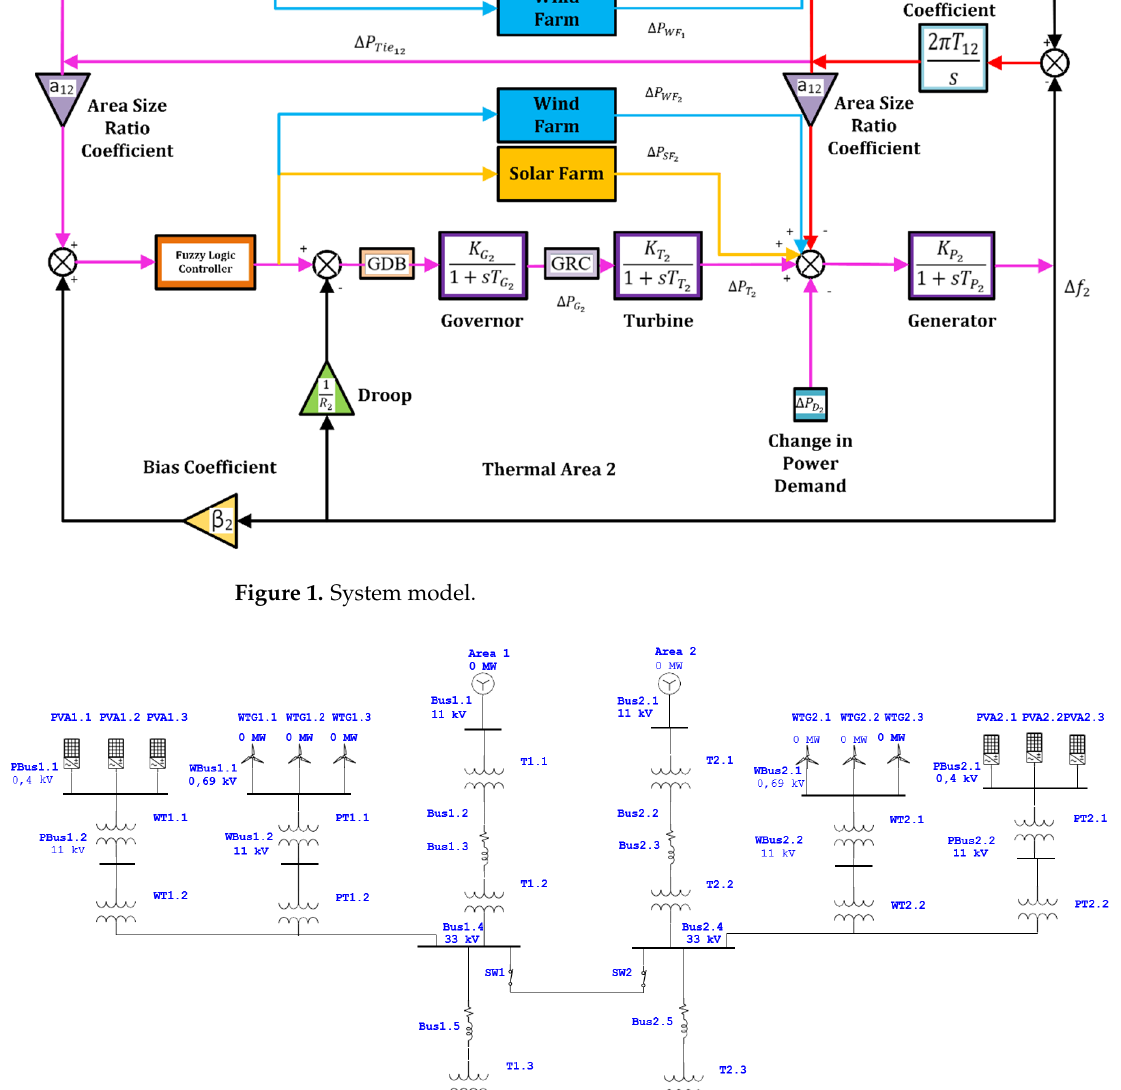
Figure 2. Single-line electrical diagram of interconnected system using ETAP software.